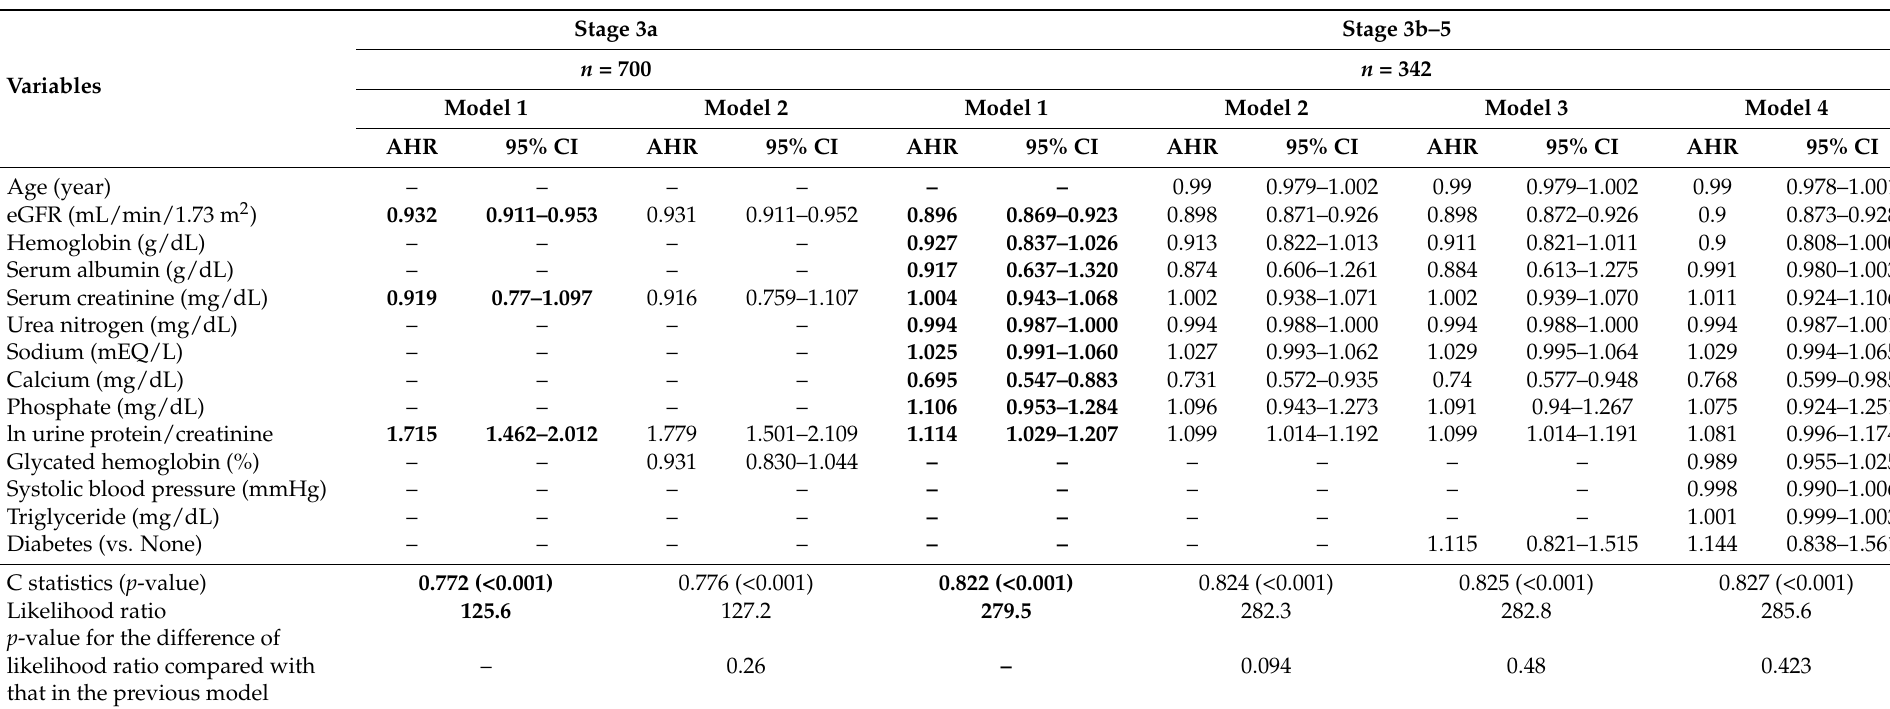
Table 4. Adjusted hazard ratios (AHR) for the effects and goodness of fit of the variables associated with the risk of dialysis treatment in the dynamic